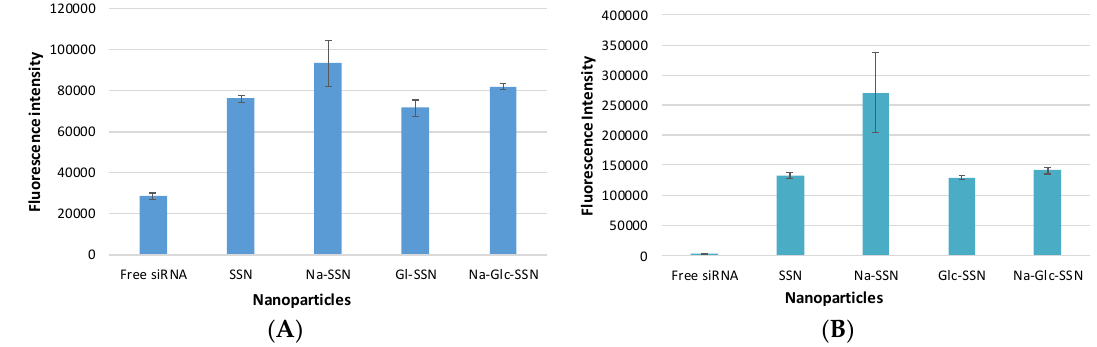
Figure 12. Fluorescence intensity of cell lysates. MCF-7 cells were treated with free siRNA, and NPs-siRNA formed with 60 mM of SrCl 2 and 10 nM AF-488 negative control siRNA. After ( A ) 4 h and ( B ) 12 h, fluorescence intensity of cell lysates was measured. Values are representative of duplicate samples.